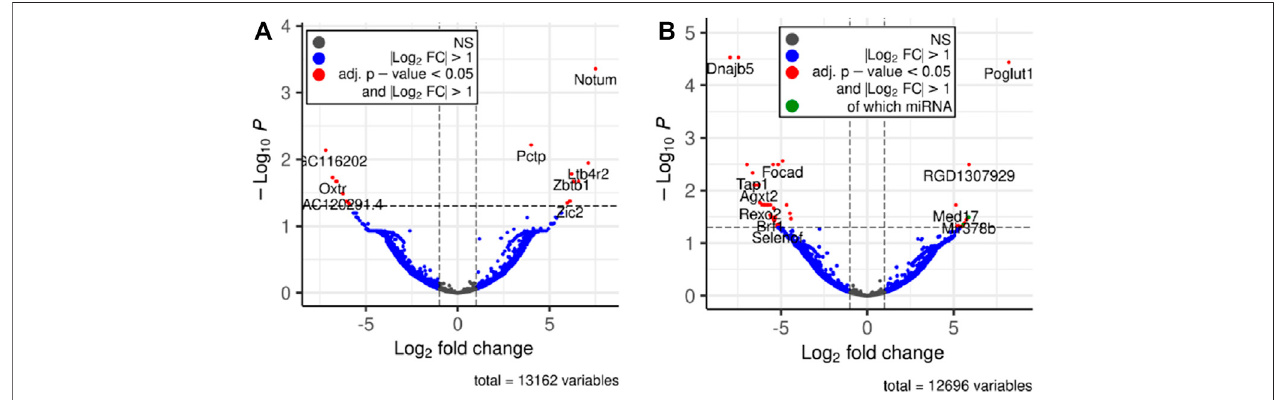
FIGURE 3 | Volcano plots depicting signi fi cant changes in the EV-enclosed RNA content. (A) Post-RUN vs. Pre-RUN EVs from exercised rats. (B) Pre-RUN EVs from exercised rats vs. EVs from sedentary control group rats.